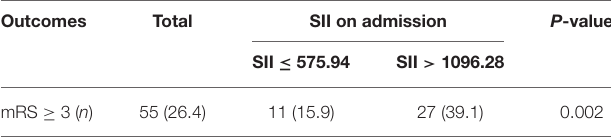
TABLE 3 | Comparison of outcomes between low SII and high